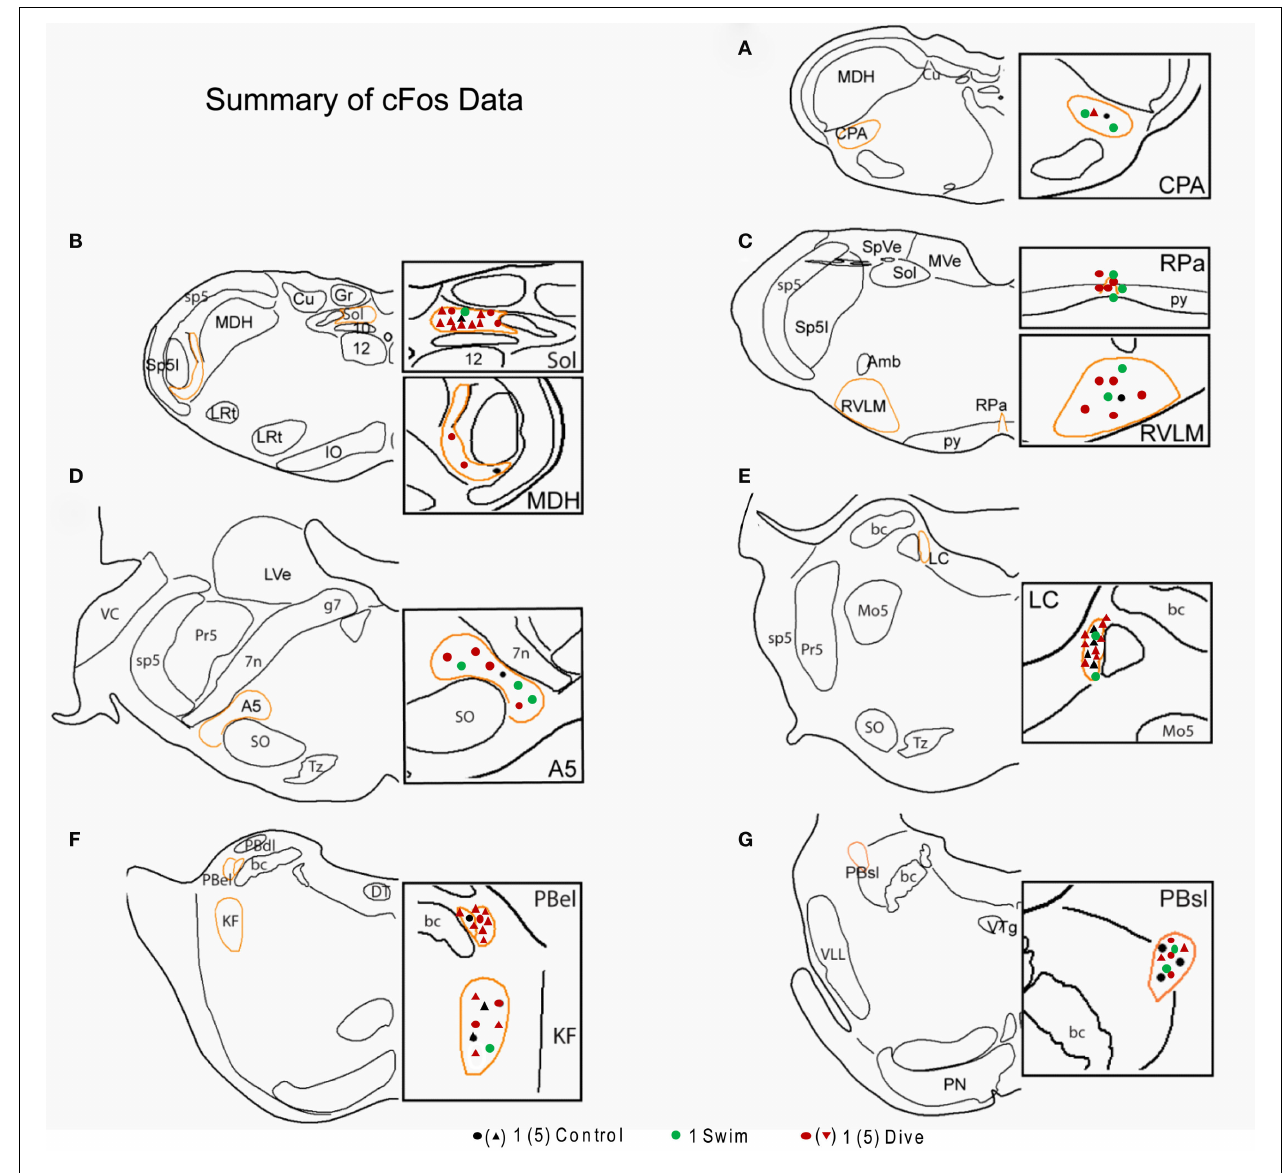
to control or swimming animals. Areas circumscribed in orange outlines the area demarcated for threshold determination; these areas are magnified in the boxes on the right of the drawing. Each dot represents a single neuron while triangles represent five neurons. See Figure 4 for